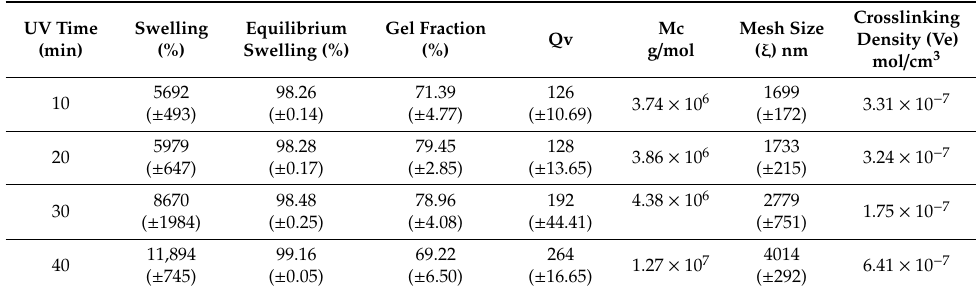
Table 3. Swelling, mesh size, and cross-linking behaviour of HA5-PT20 hydrogels crosslinked by the UV irradiation